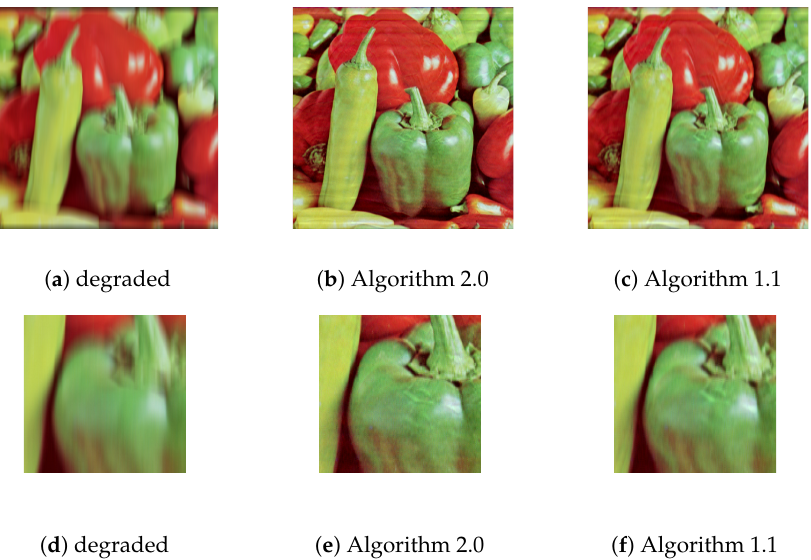
Figure 7. Degraded and restored ( a – c ) Pepper images ( d – f ) enlarged Pepper images by the various